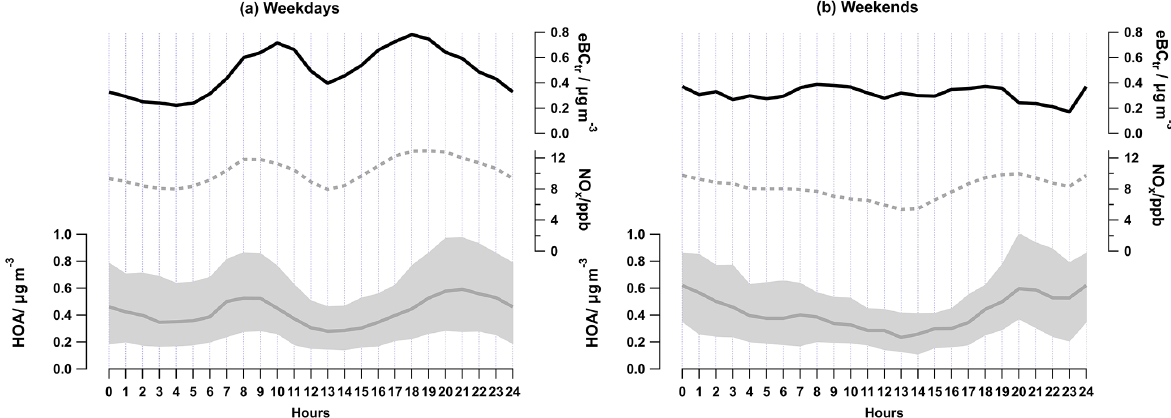
Figure 6. Diurnal cycles of HOA (grey symbols), black carbon apportioned to traffic emissions eBC tr (dashed lines), and NO x (dotted lines) for weekdays (a) and weekends (b) . The shaded areas represent the interquartile range for HOA (1h